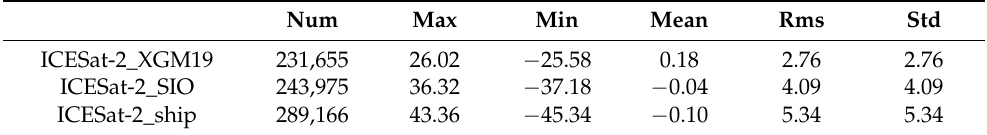
Table 18. Statistics of differences between the along-beam DOV-derived gravity anomalies and